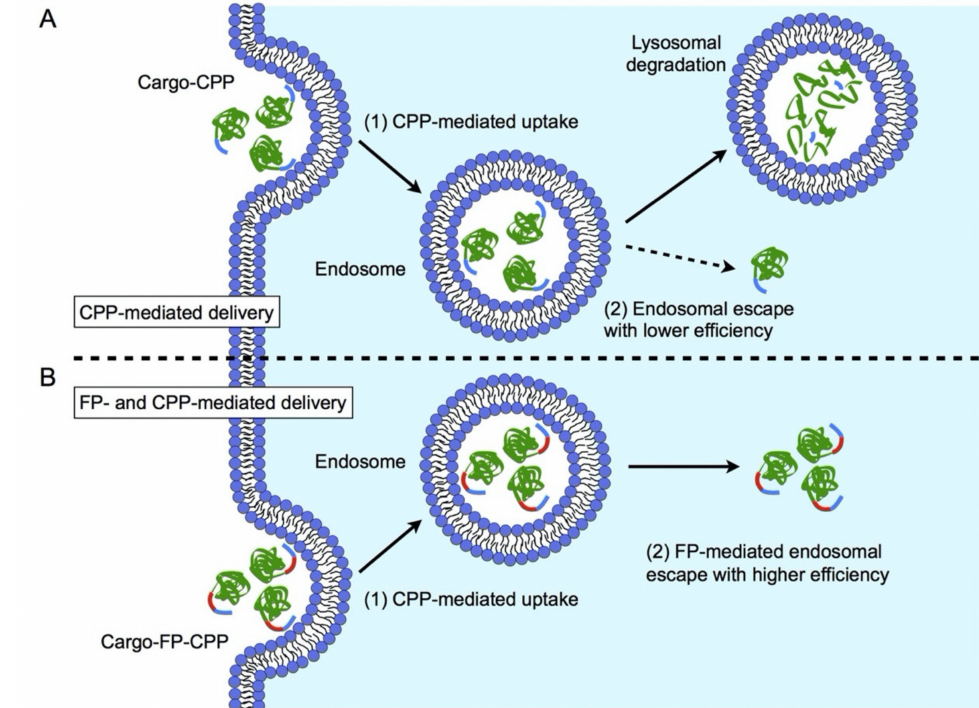
Figure 4. Schematic representation of FP and CPP-mediated delivery. ( A ) A conventional CPP- mediated delivery. (1) ( A ) cationic CPP (blue) interacts electrostatically with the anionic cell-surface, and a CPP-fused cargo (green) is internalized into the endosome by endocytosis. (2) Because the endosomal escape efficiency of CPP is low, the cargo-CPP is subjected to lysosomal degradation. ( B ) FP- and CPP-mediated delivery. (1) An FP (red)- and CPP-fused cargo is internalized into the endosome by endocytosis. (2) Because the efficiency of FP-mediated endosomal escape is relatively high, the cargo-FP-CPP is efficiently transferred from the endosome to the cytoplasm. Reprinted with permission from [142]. Copyright 2017